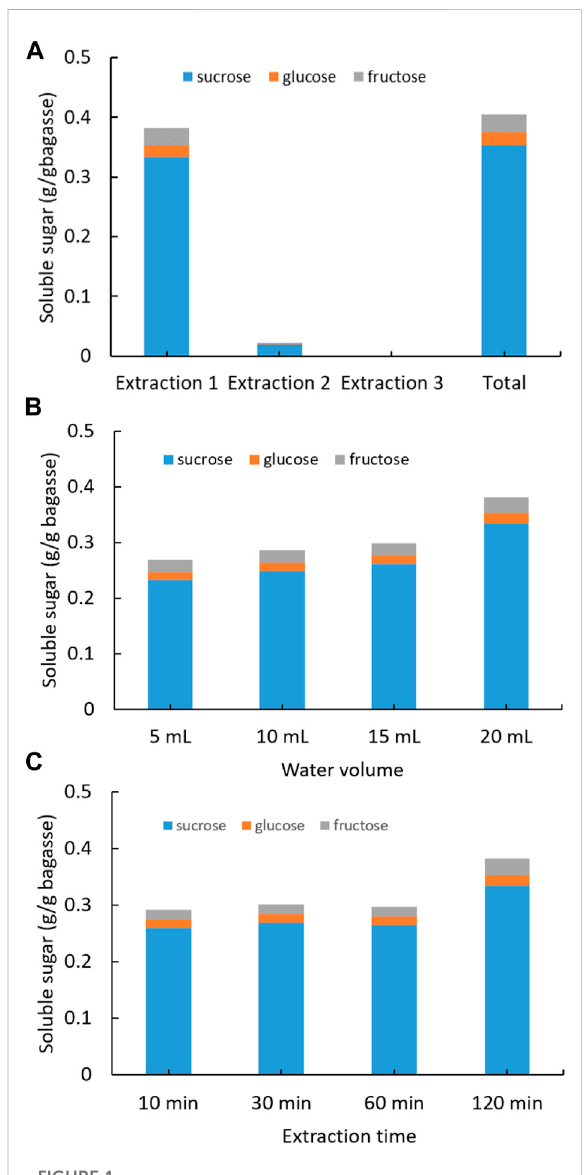
FIGURE 1 Extraction of soluble sugars from SCB with water under different conditions: (A) three consecutive extractions, (B) varying water volume, and (C) varying extraction time. (Standard deviation ≤ 5% for sucrose, glucose, and fructose).